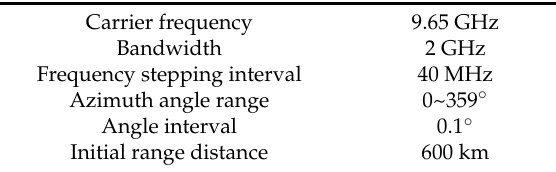
Figure 20. 20° bistatic angle SAR image of the orthogonal dihedral corner ( a ) geometric configuration; ( b ) imaging result. The monostatic SAR image of the orthogonal dihedral generates a strong point-like target, which is quite different with its geometric shape. The point-like image coincides with the previous analysis, which indicates that the brightest point locates at the connection point of the dihedral corner. For the bistatic SAR, the pixel values are much lower than the monostatic one and the image responses to the endpoints of two planes. Therefore, it can be concluded that monostatic SAR sensors are more sensible for orthogonal dihedral corners. 4.2. Obtuse Dihedral Reflector Changing the opening angle of the reflector, its behavior in SAR images becomes different. Setting the experimental object as an obtuse dihedral corner reflector, we use monostatic SAR and bistatic SAR to image it. Based on the previous analysis, the monostatic SAR for this target will not appear the dihedral effect, such as in Figure 19. In Figure 21, the maximum pixel value is around 0 dB. If the bistatic angle is not suitable for this dihedral corner, there will be the same situation. At first, we use an unsuitable configuration, 20° bistatic angle, to image it. The result is shown in Figure 22. The pixel value of the original point in Figure 22 is also around 0 dB, which is almost no difference with the monostatic case. It is difficult to get the dihedral effect under inappropriate